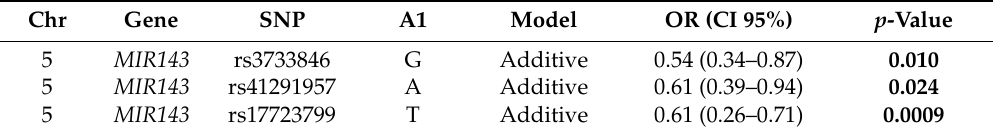
Table 4. Logistic regression analysis of MIR143 SNPs in association with NHL showing p -values after adjusting for covariate ‘sex’. A1, minor allele.